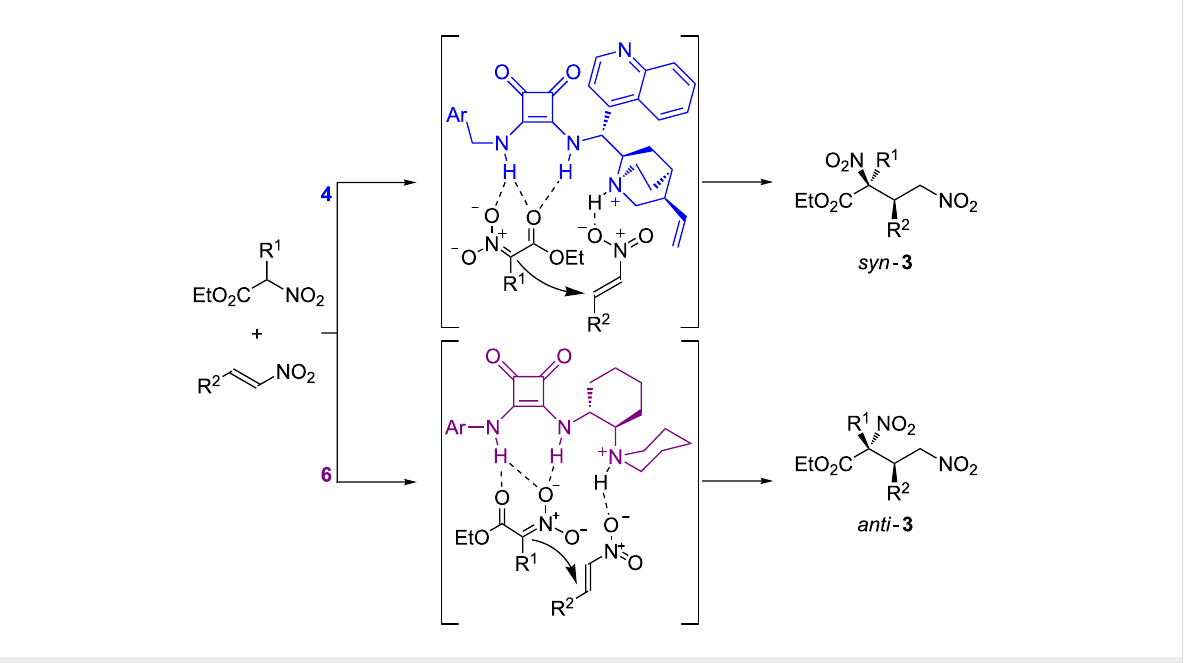
Scheme 3: Proposed models to explain the stereochemical outcome of the reaction.